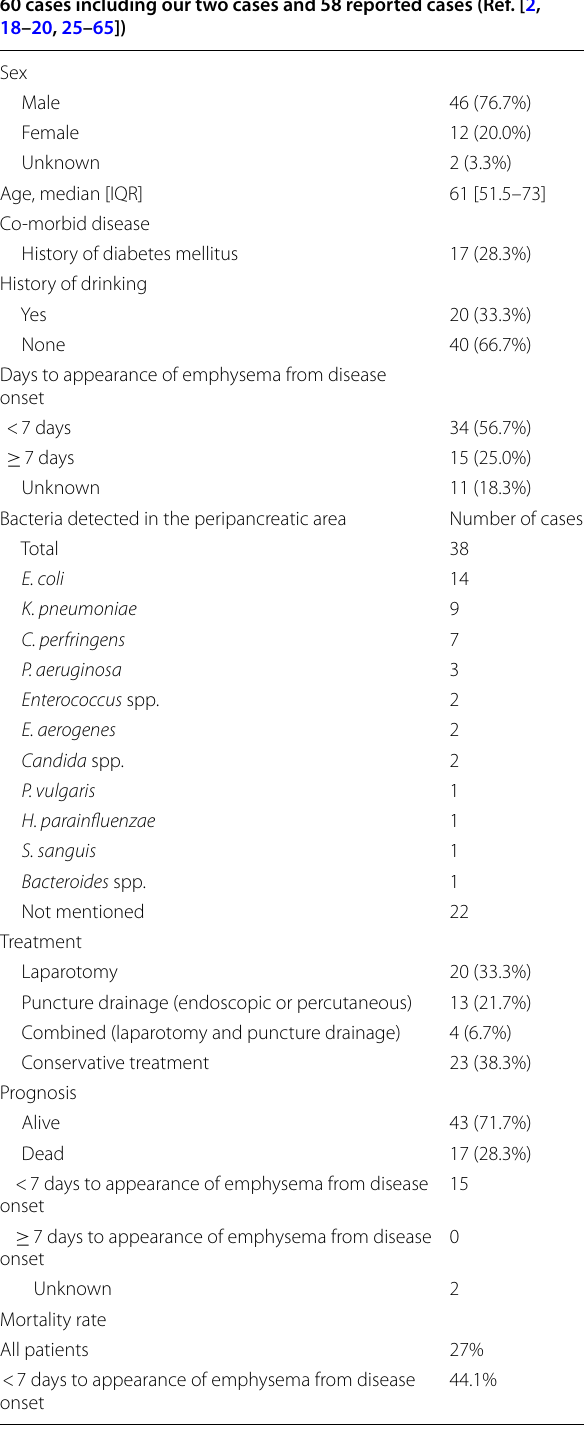
Table 1 A summary of necrotizing pancreatitis with